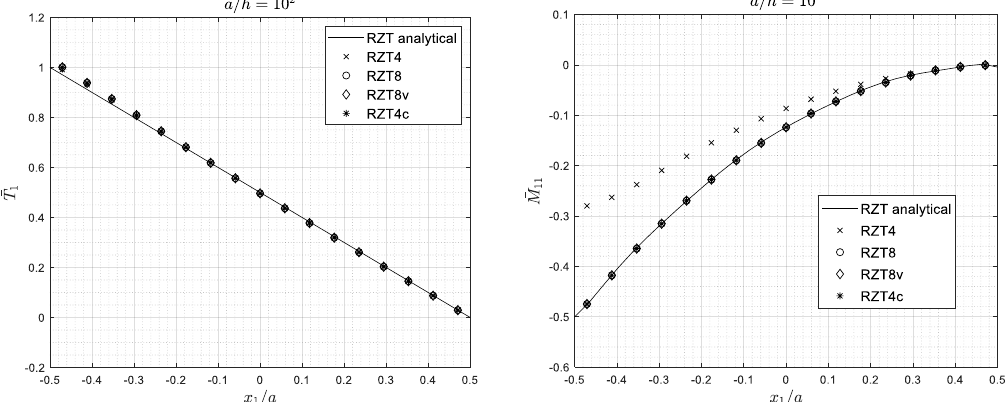
Figure 15. Cantilever thin sandwich (S) square plate under uniform transverse pressure (C1). Transverse shear force and bending moment distribution.